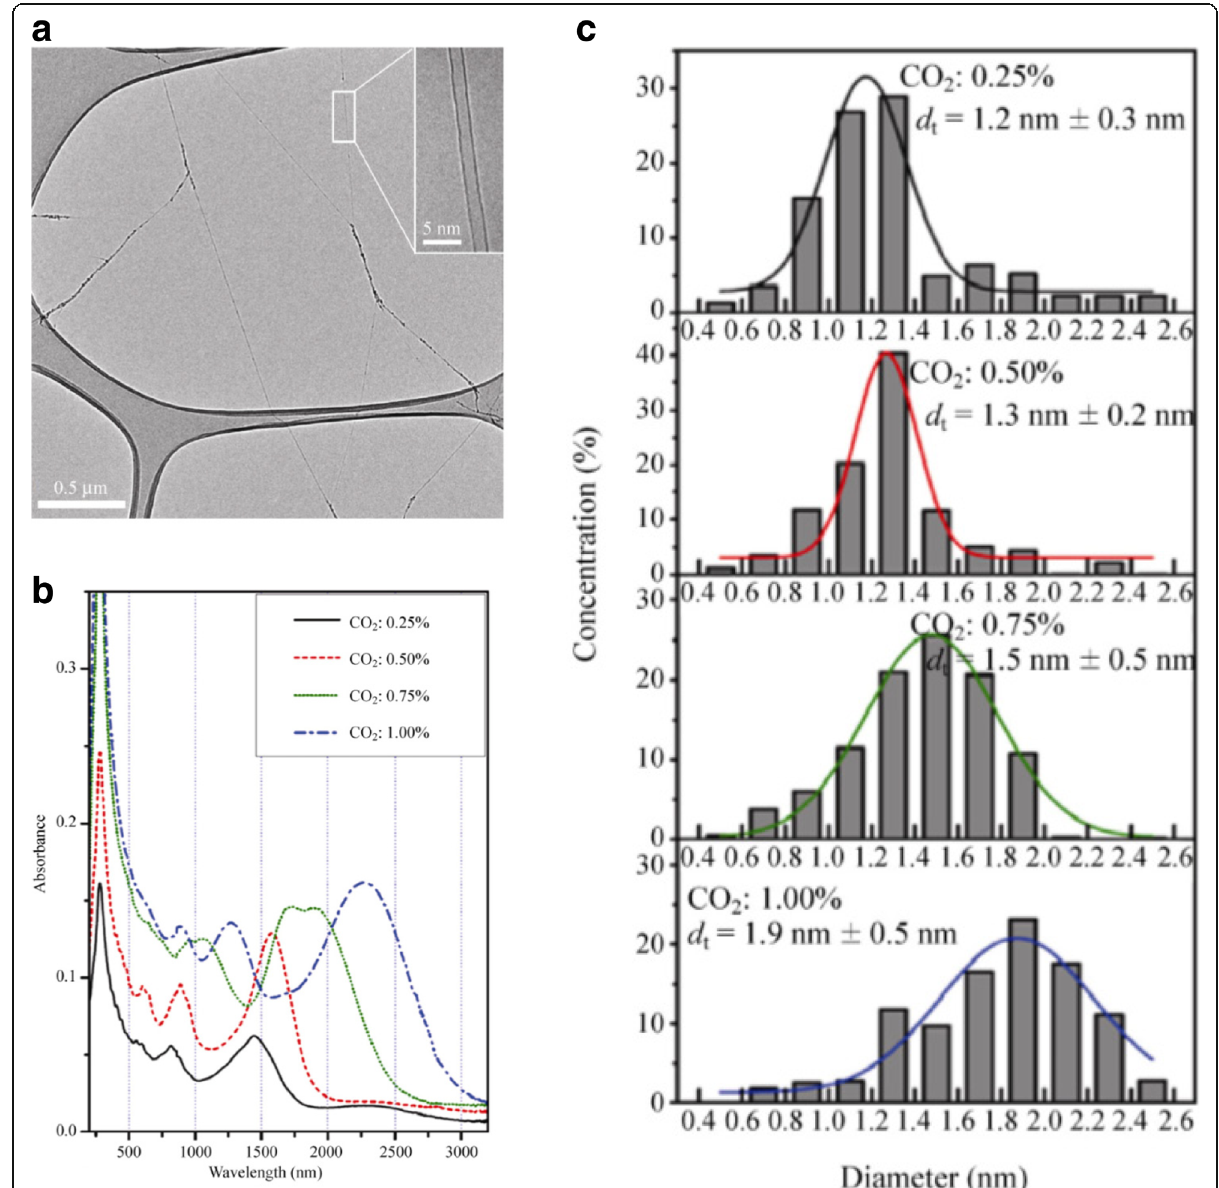
Fig. 15 a TEM image of SWCNTs grown by adding CO 2 along with carbon source. (Inset) shows the TEM image of an individual SWCNT Adapted from [142]. b Plot showing the absorption vs wavelength of SWCNTs grown with different CO 2 concentrations. Adapted from [142]. c The corresponding diameter distributions of SWCNT samples with different CO 2 concentrations. Adapted from